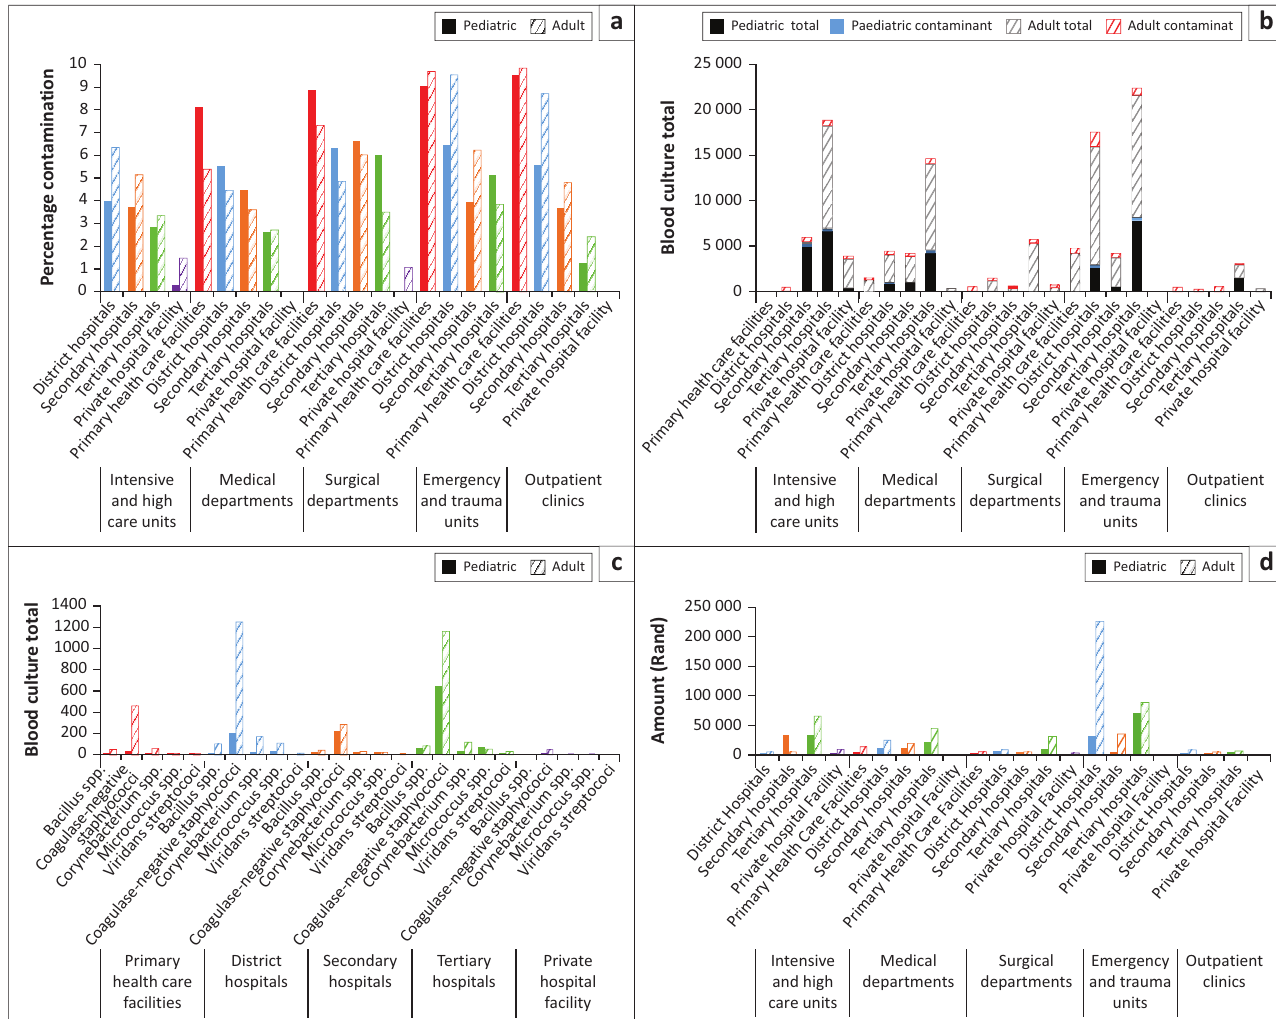
FIGURE 2: (a) Blood culture contamination rates at different level hospitals and departments in the Cape Town Metropole; (b) Total amount of blood cultures collected with the proportion of contaminating microorganisms cultured; (c) Contaminating microorganisms from processed blood cultures; (d) Blood culture collection consumables and laboratory culturing costs at the National Health Laboratory Service, Groote Schuur Hospital. The study period is between 01 January 2016 and 31 December 2018. The private hospital facility has no emergency or trauma unit. Primary healthcare facilities have no intensive care